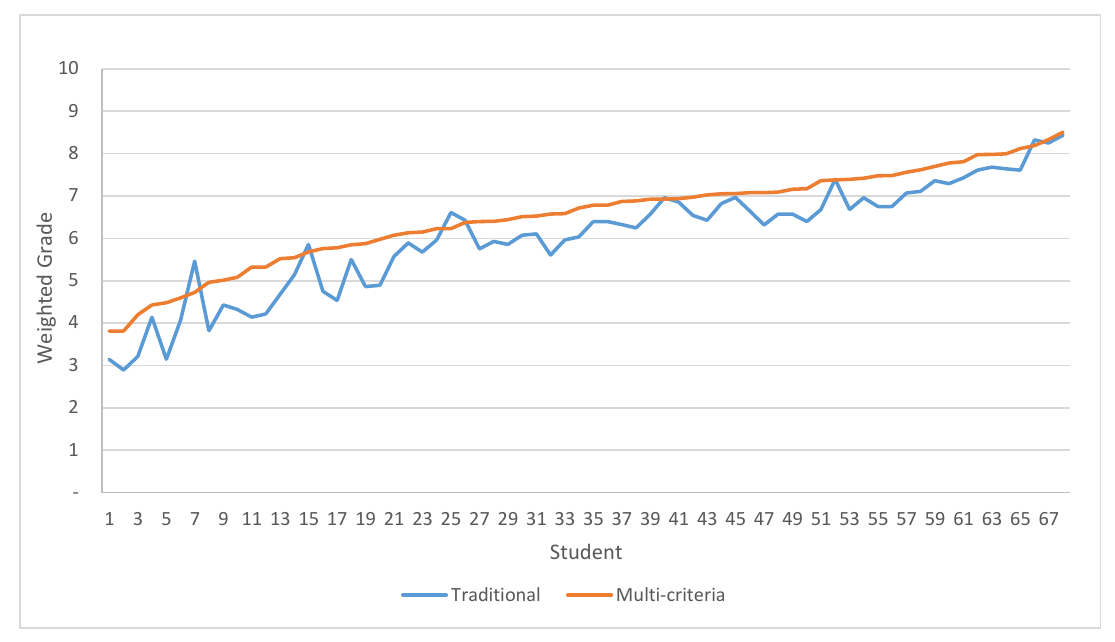
Figure 4. Comparison of results between traditional and multi ‐ criteria Evaluation Methods.